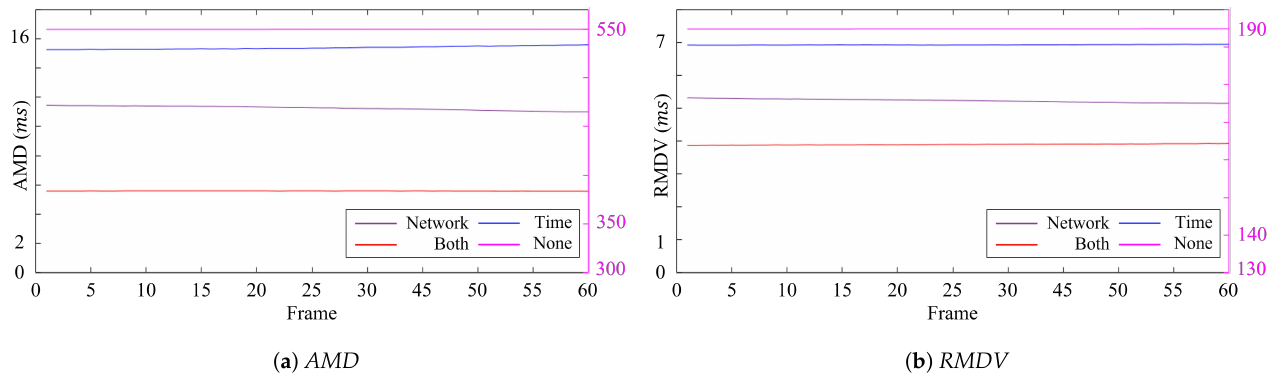
Figure 9. Errors of 15 FPS according to the delay for each frame (ms).